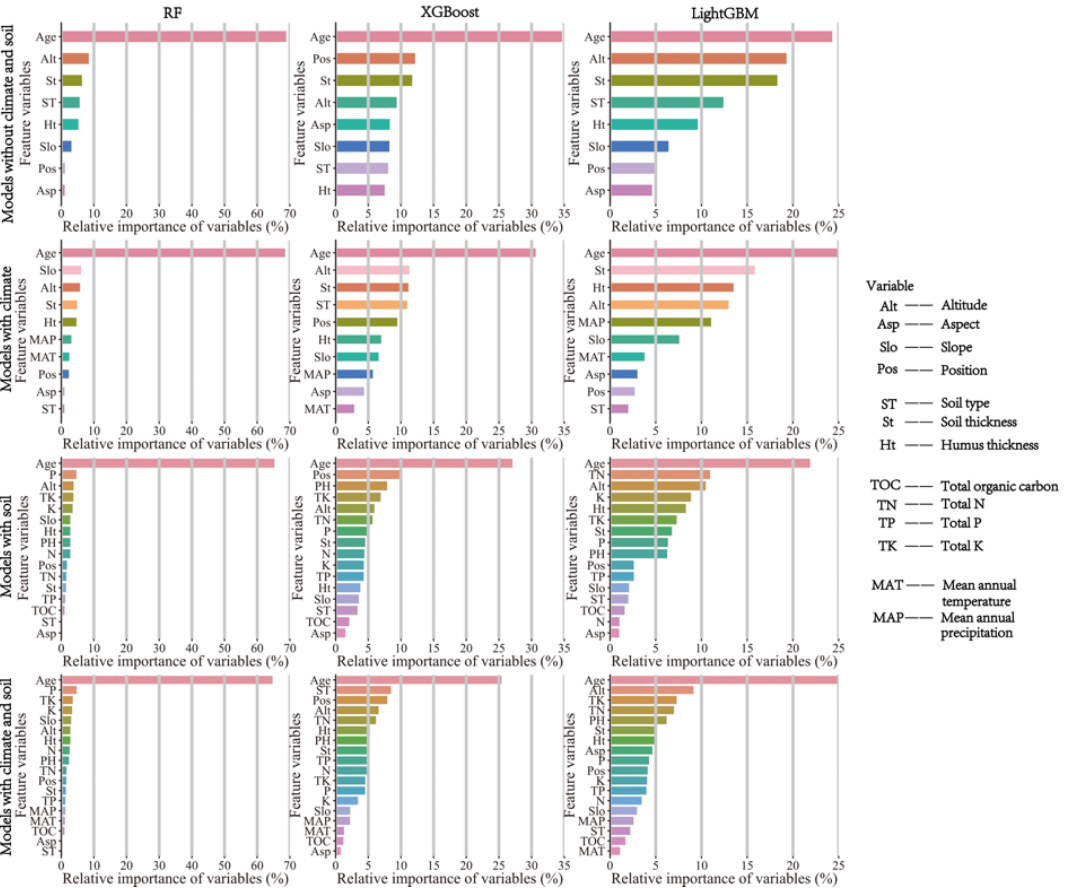
Figure 4. Ranking of the importance of different types of variables affecting the dominant height of the stand of Pinus massoniana using machine ‐ learning algorithms (RF, XGBoost, and LightGBM).